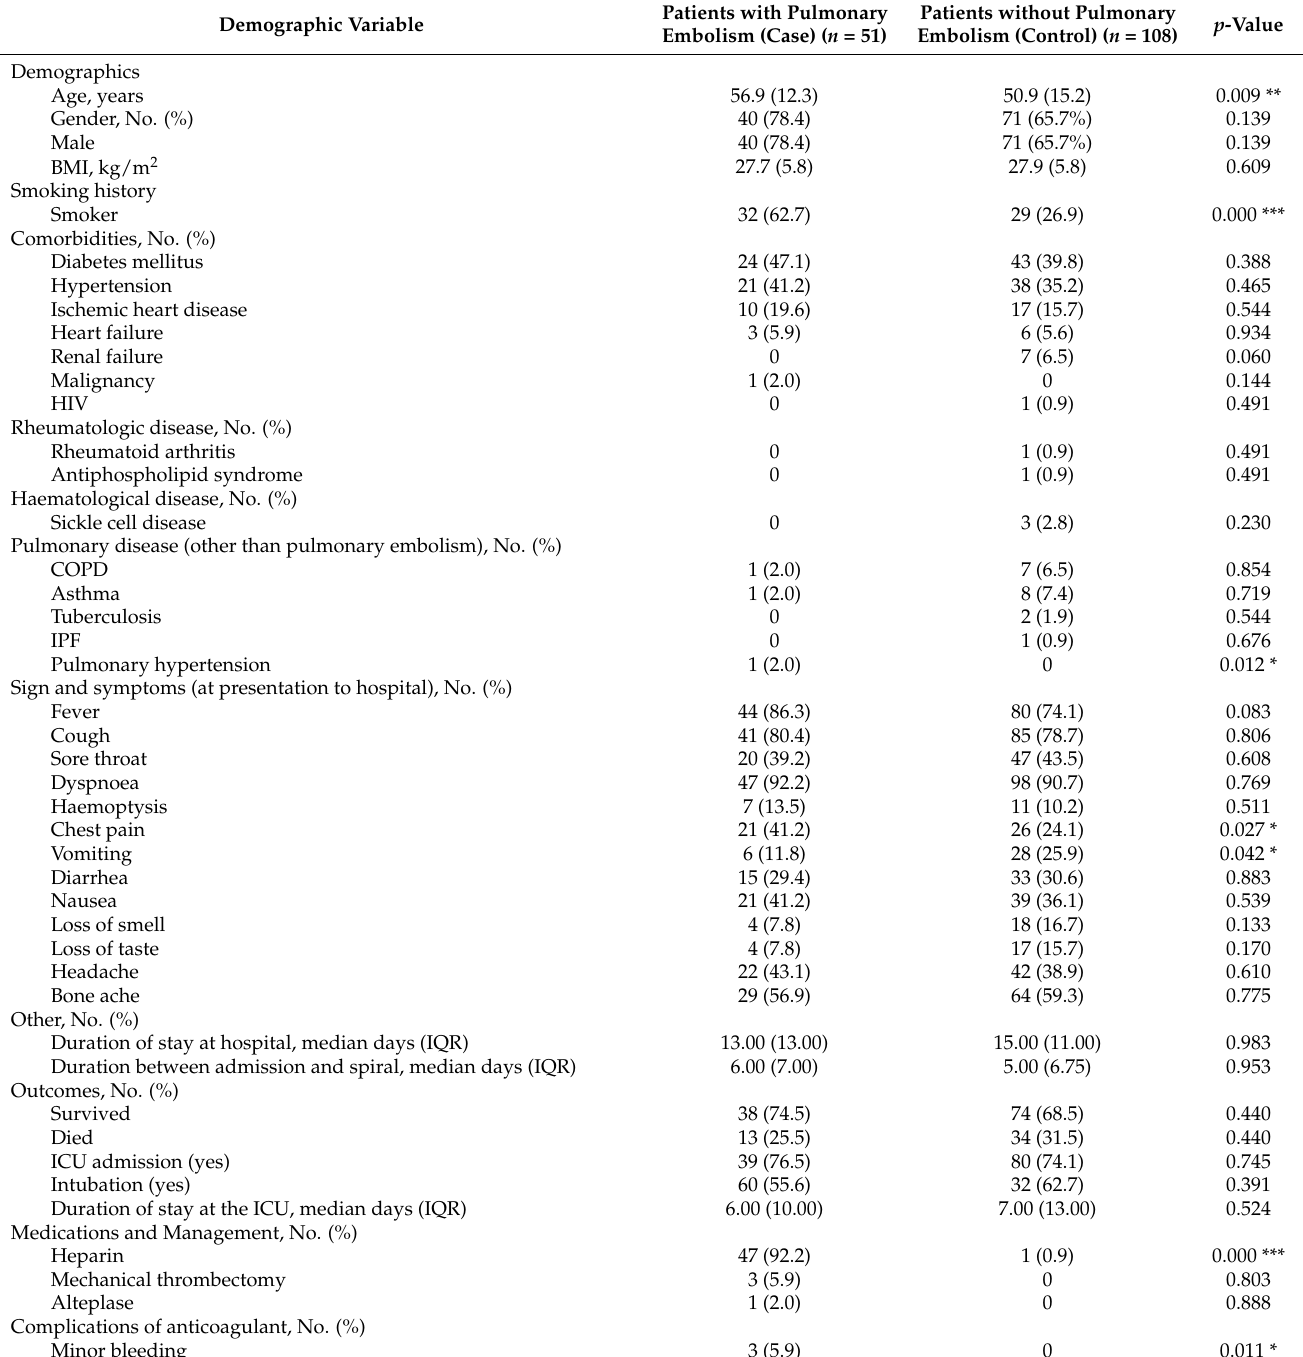
Table 1. Baseline characteristics for the study